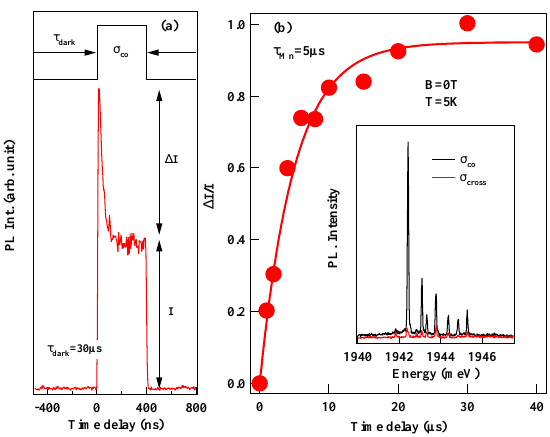
Figure 2: (a) Time evolution of the PL intensity recorded at B = 0 T and T = 5 K on the high energy line of a Mn-doped QD under the quasi-resonant (QD excited state) excitation sequence displayed on the top. An intensity transient induced by the optical pumping of the Mn spin appears at the beginning of the circularly polarized ex- citation pulse. (b) Evolution of the amplitude of the optical pumping transient ∆I / I as a function of the dark time between the excitation pulses. A relaxation time τ Mn = 5 µ s is measured at B = 0 T. The in- set shows the co and cross circularly polarized PL of the exciton-Mn complex.